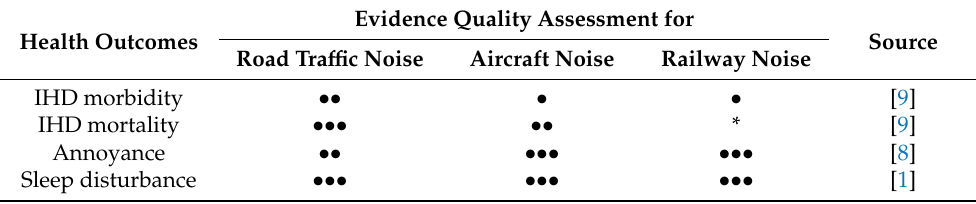
Table 1. Evidence on the association between tra ffi c noise exposure and health